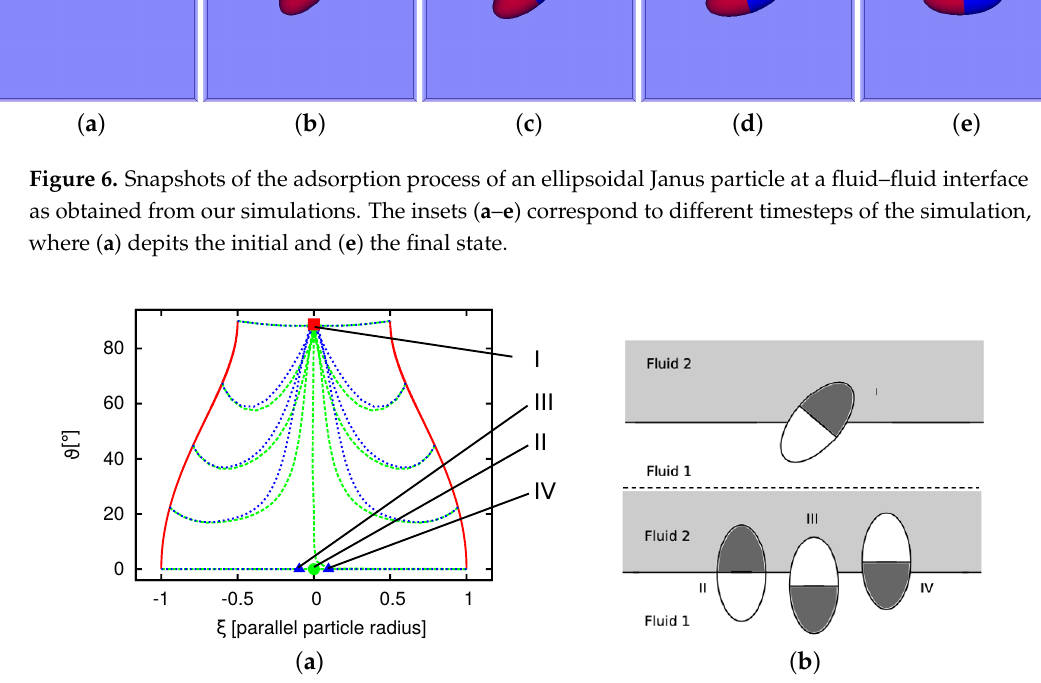
Figure 7. ( a ) Adsorption trajectories ( ϑ (cid:48) - ξ -plot) of a single Janus particle at a flat interface for m = 2 and ∆ θ ≈ 2 ◦ . The dashed and dotted lines represent the trajectories for the PIO and UIO, respectively. The following types of end points or final states (characterized by ξ and ϑ (cid:48) ) are shown: The square indicates the end point of both dashed and dotted lines. The circle and triangles show the exclusive end points of dashed and dotted lines, respectively. The Roman numerals relate the points for the final states to the following sketches: ( b ) Sketch of the tilted state (“I”, 0 < ϑ (cid:48) < 90 and ξ = 0) corresponding to the square in ( a ) (upper end point) and the metastable states for different cases of the upright orientation ϑ (cid:48) = 0 (“II”). Left particle: every wetting area is immersed completely in its preferred fluid. ϑ = 0, ξ = 0 (related to the circle in ( a )). Middle (“III”) and right (“IV”) particle: one wetting area is completely and the other one partly inside its unpreferred fluid. ϑ = 180 ◦ , ± ξ unpr (related to both triangles in ( a ) and given in Equation (29)). The interface is flat for all three final